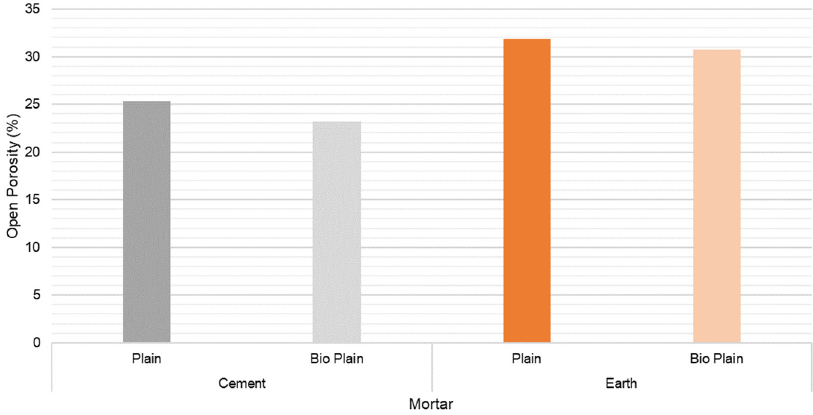
Figure 21. Open porosity at 28 days for the cement-based mortar with and without biostabiliser. Coefficient of variation (CoV) per family of mortar: cement mortar: 1.8%; cem+bio: 3.2%; earth mortar: 1.2%; earth+bio: 0.5%.